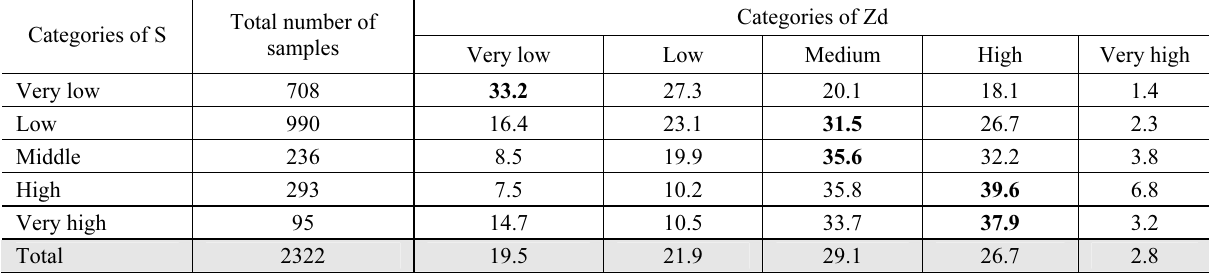
Table 1. Correspondence between percentage of categories of Zd and S indices